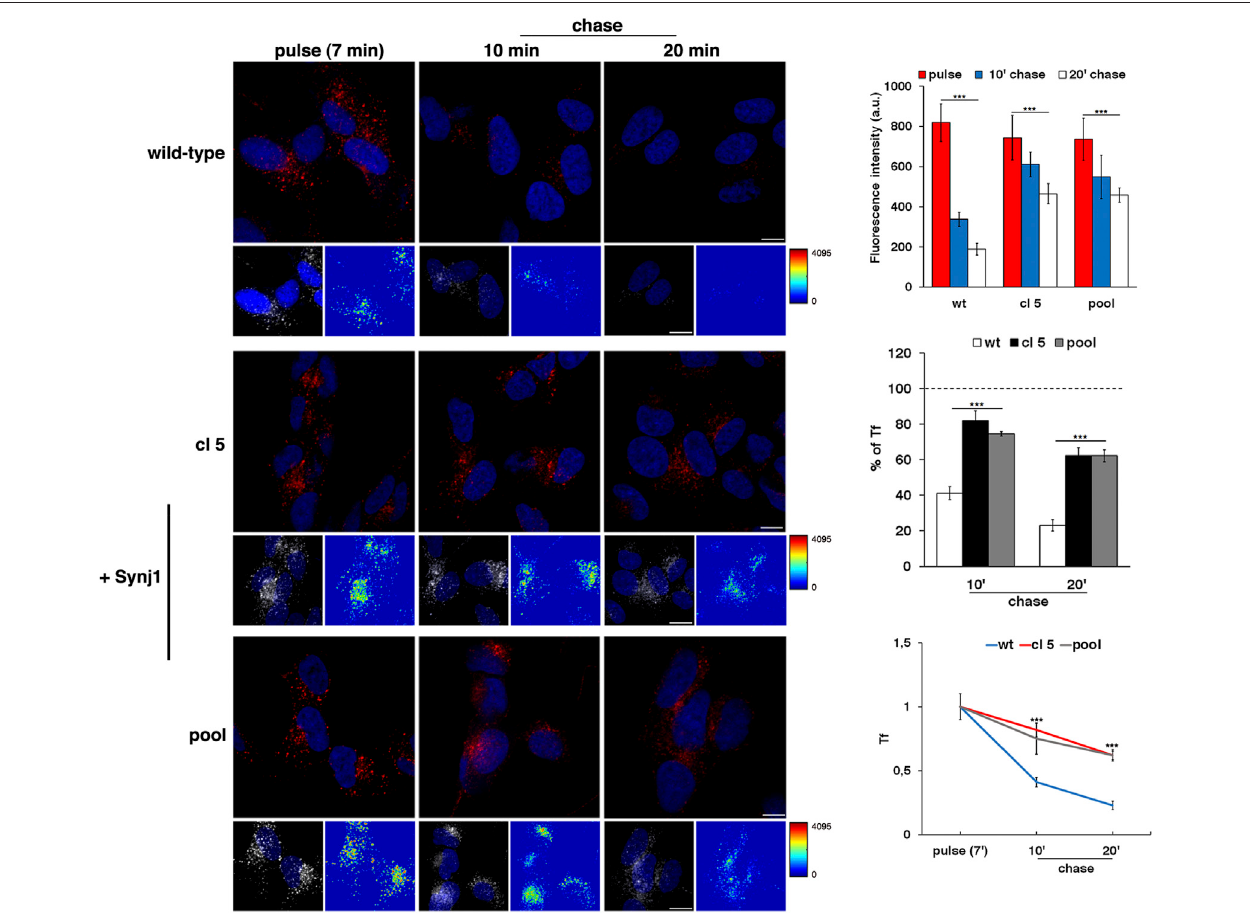
FIGURE 7| The recycling traf fi cking is perturbed in Synj1-overexpressing SH-SY5Y cells. The internalization assay ofAlexa-546-conjugated transferrin (Tf) in wild- type and Synj1-overexpressing (+Synj1) SH-SY5Y cells was performed as in Figure 4A . Representative confocal images, 3D reconstruction of an area of the fi eld and the corresponding intensity maps are shown; scale bars, 8 μ m. Mean fl uorescence intensity was measured at the different time points and expressed as arbitrary unit (a.u.;uppergraph)orasthepercentageof fl uorescencedetectedatthepulse(setto100%)(middlegraph);errorbars,mean±SDoftwoindependentexperiments, n ≥ 50cells.CurvesofTfinternalizationexpressedasmeanvaluesof fl uorescencemeasuredatchasetimescomparedwiththe fl uorescentsignalafterthepulse(setto1) are shown (lower graph). *** p < 0.001, Student ’ s t-test